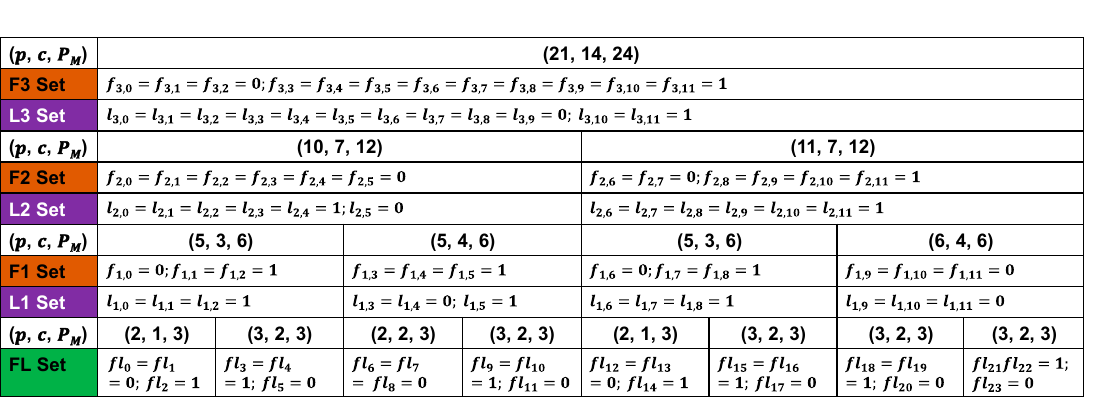
Figure 28. Control signal table for ( p , c, 𝑃 (cid:3014) ) = (21, 14, 24).